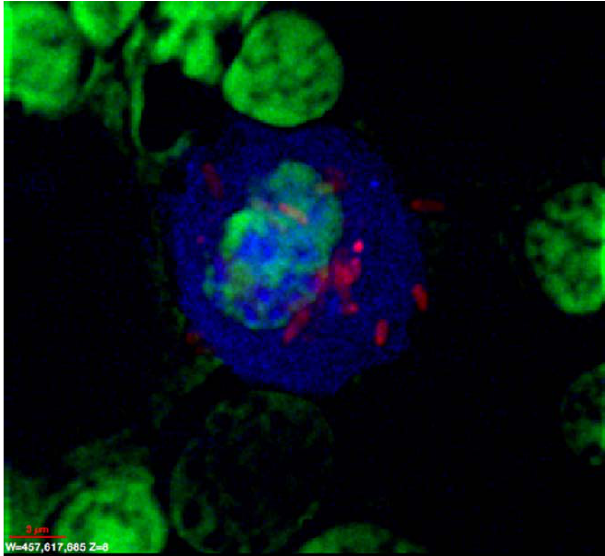
Figure 2. Microscopic Analysis of a Blue Spleen Cell Containing Intracellular Salmonella Mice were infected i.p. for 48 hours with 14028 expressing a chromosomal SteA-Bla construct and harboring pWKS30-Tomato, a red fluorescent protein expression vector (shown in red). Spleen cell suspensions were prepared then loaded with CCF2-AM (blue) to detect secretion and a DNA stain, DRAQ5 (green), to visualize nuclei. The image was taken at 60 3 magnification.